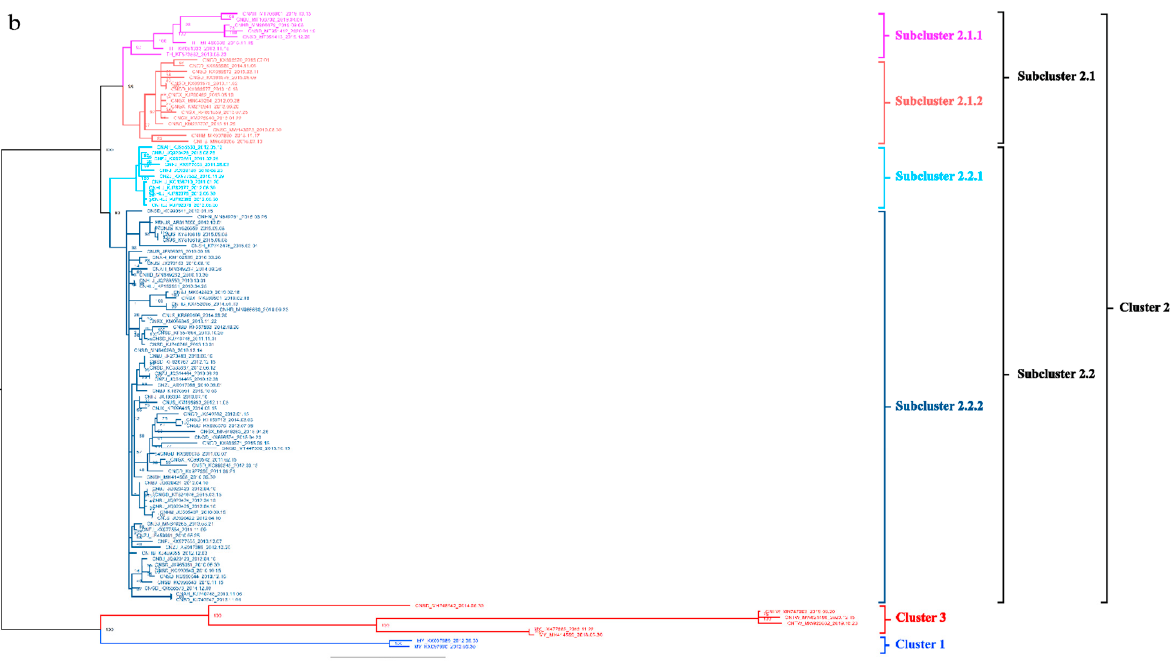
Figure 3. Phylogenetic analysis of the E gene sequences based on two different methods. ( a ) The MCC tree was scaled to time using the GTR + F + G substitution model and an uncorrected relaxed clock (lognormal) of the TMUV E gene. The different RGB colors represent different clusters. The RGB color numbers were 0740F9, FF33FF, FF6666, 00CCFF, 1D5792, and FF0000 for clusters 1, 2.1.1, 2.1.2, 2.2.1, 2.2.2, and 3, respectively. ( b ) The ML tree was reconstructed using RAxML based on GTR + F + I + G4 model.